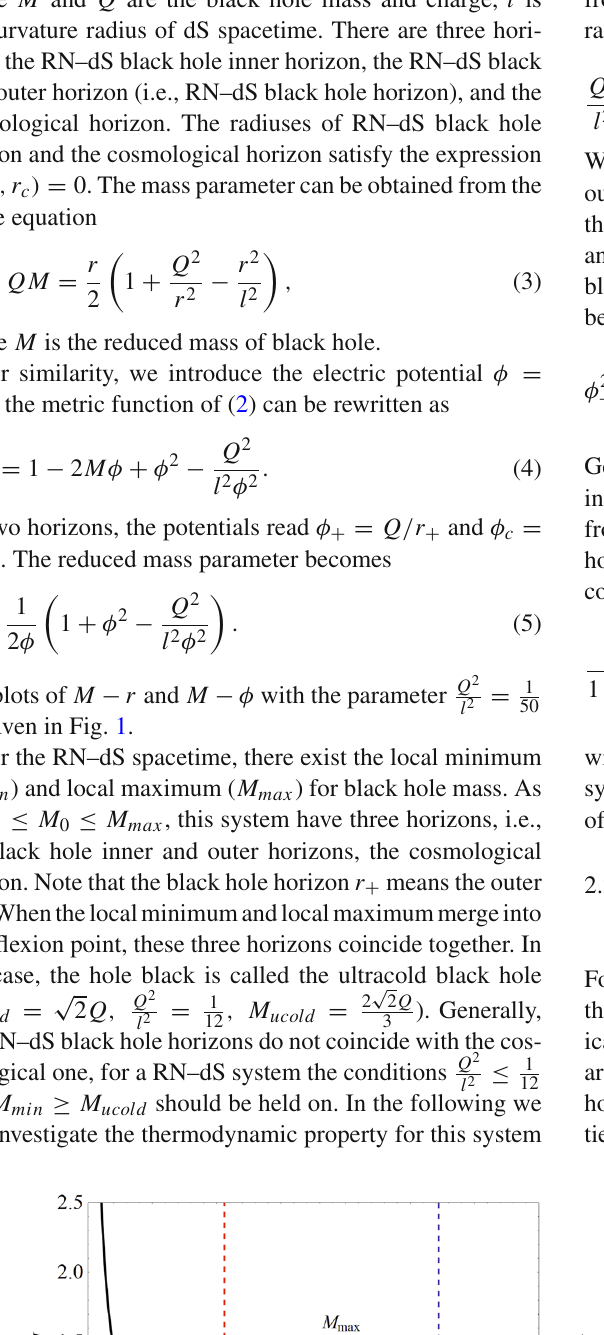
Fig. 1 The pictures of M − r and M − φ with the parameter Q 2